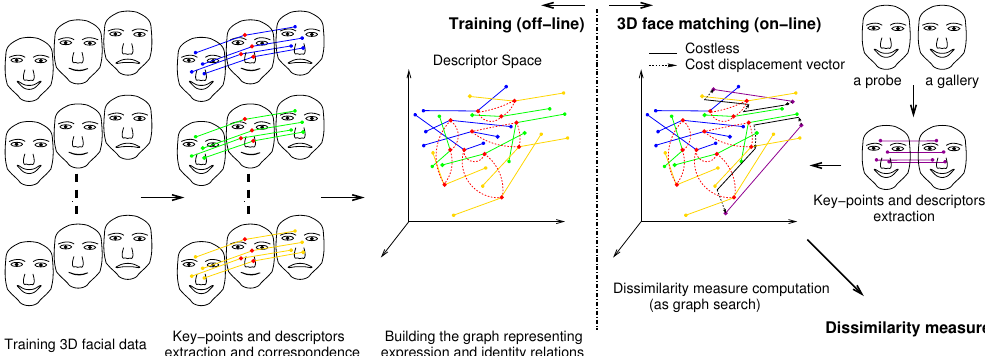
Figure 1. An Overview illustration of the proposed approach (better seen in